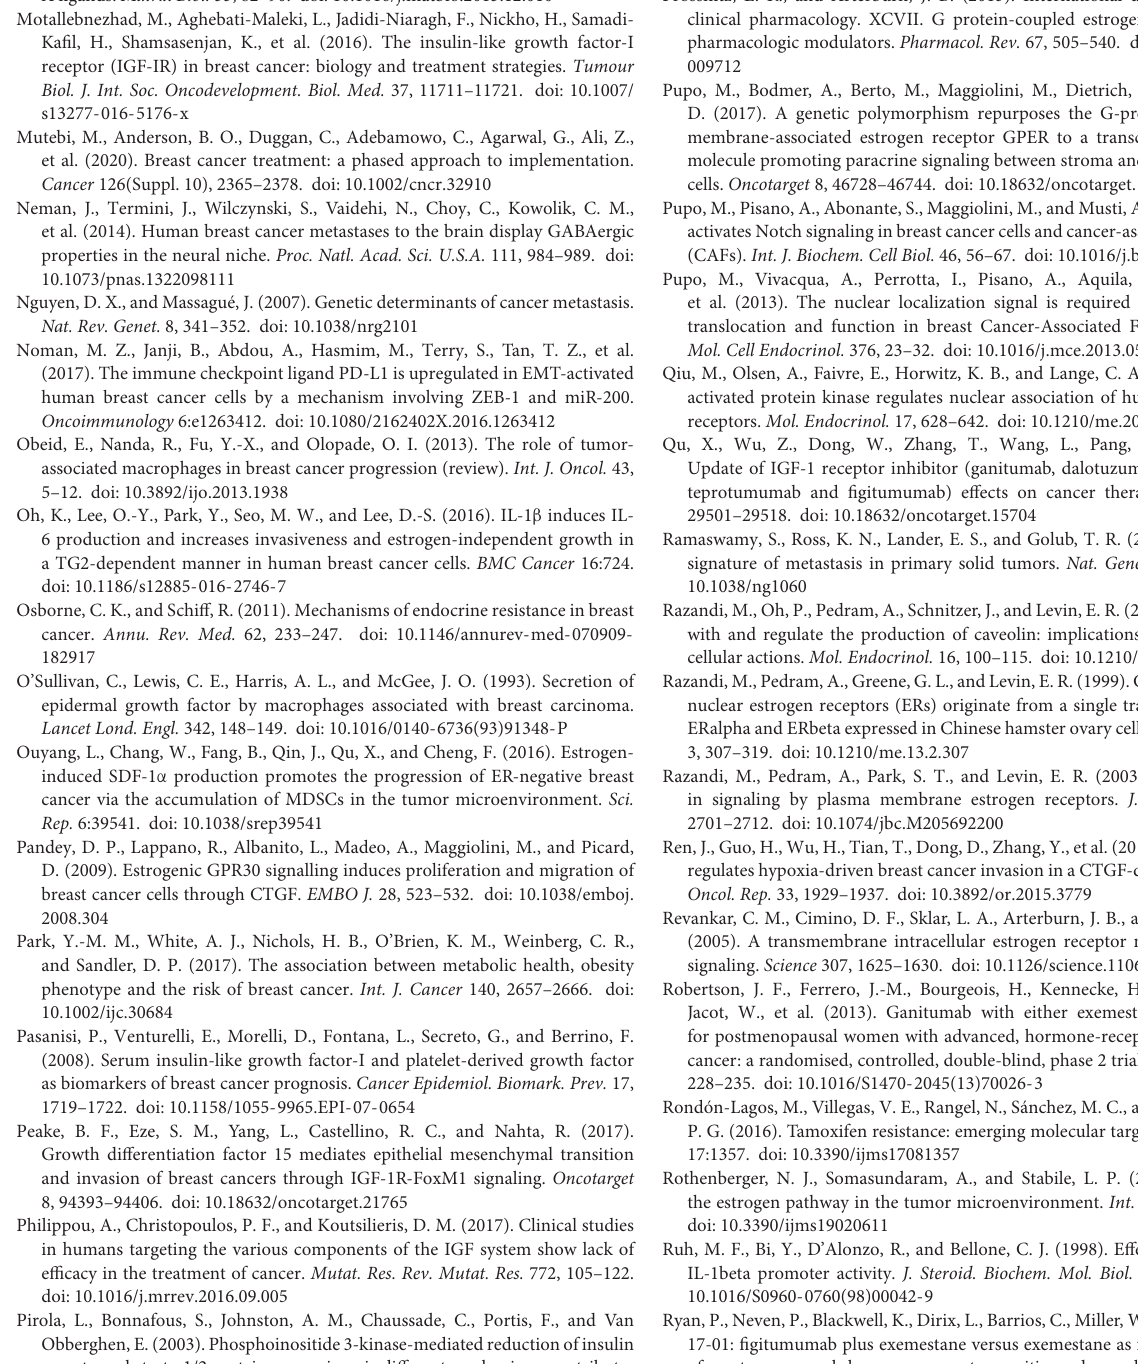
17-01: figitumumab plus exemestane versus exemestane as first-line treatment of postmenopausal hormone receptor-positive advanced breast cancer: a